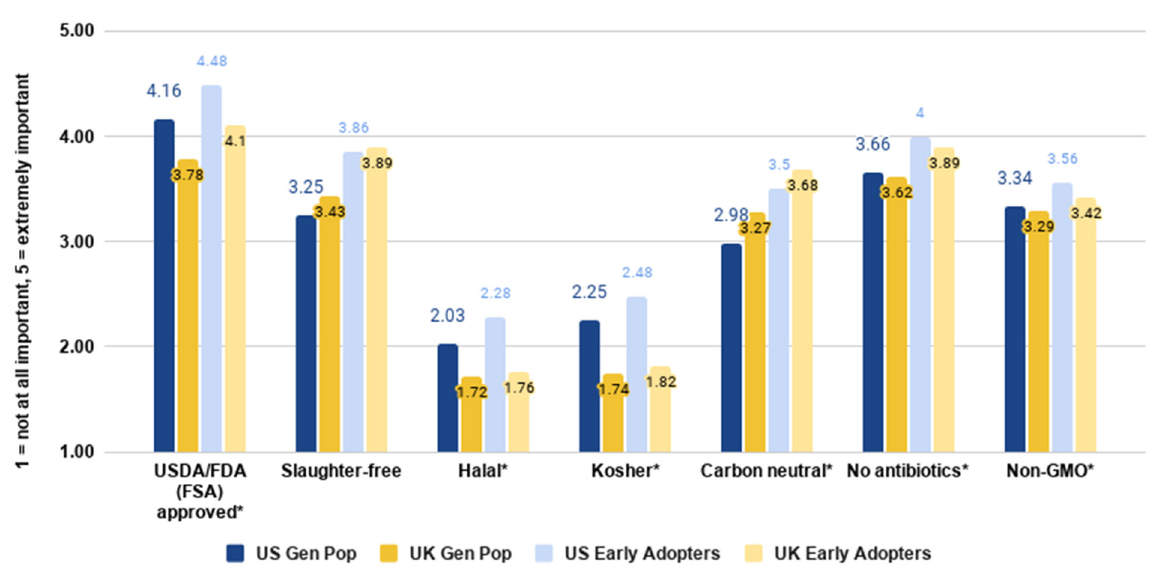
Figure 15. Importance of different seals of approval by country and segment. * indicates a significant difference between the countries on this measure.